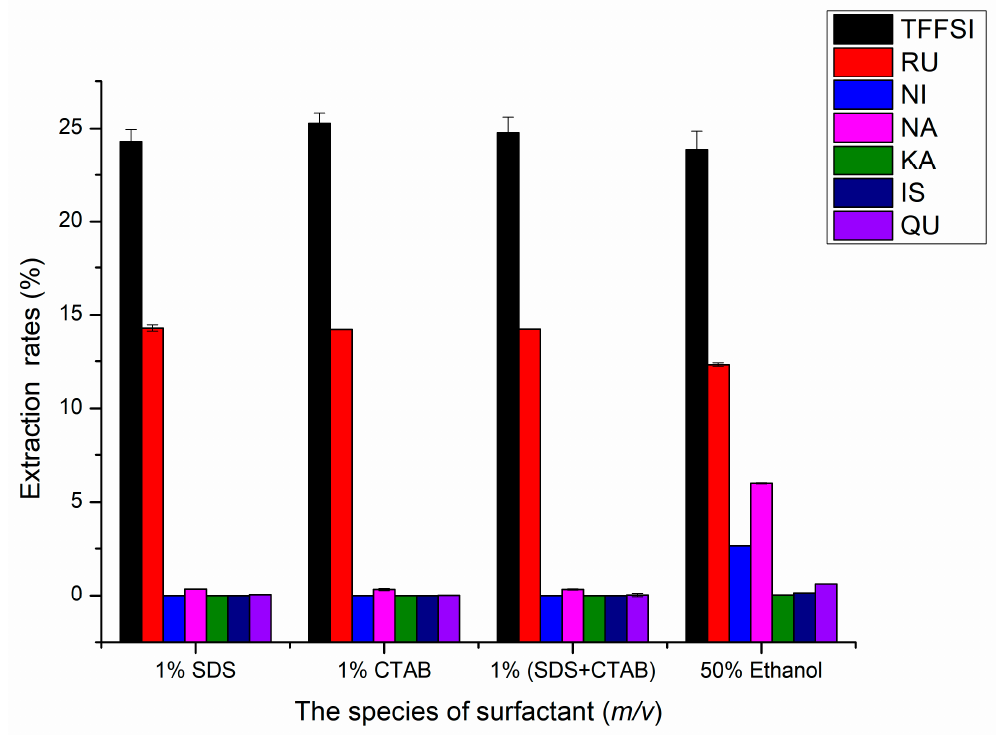
Figure 2. E ff ects of the species of surfactant on the extraction rates of RU, NI, NA, KA, IS, QU, and the TFFSI.